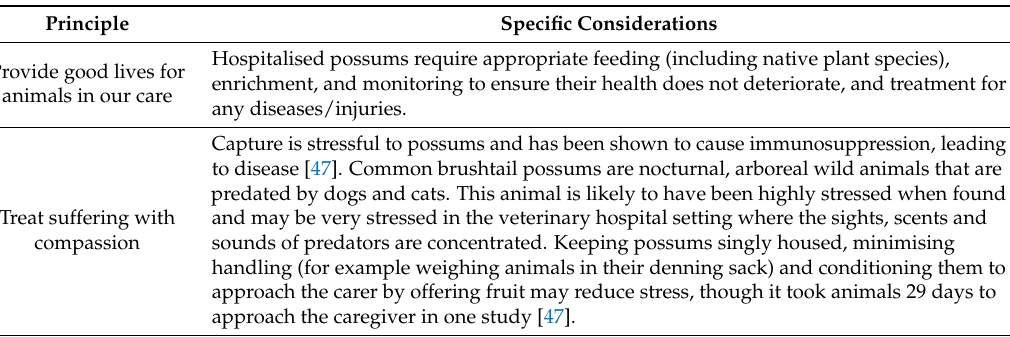
Table 4. Fraser’s “practical” ethic principles applied to wildlife treatment